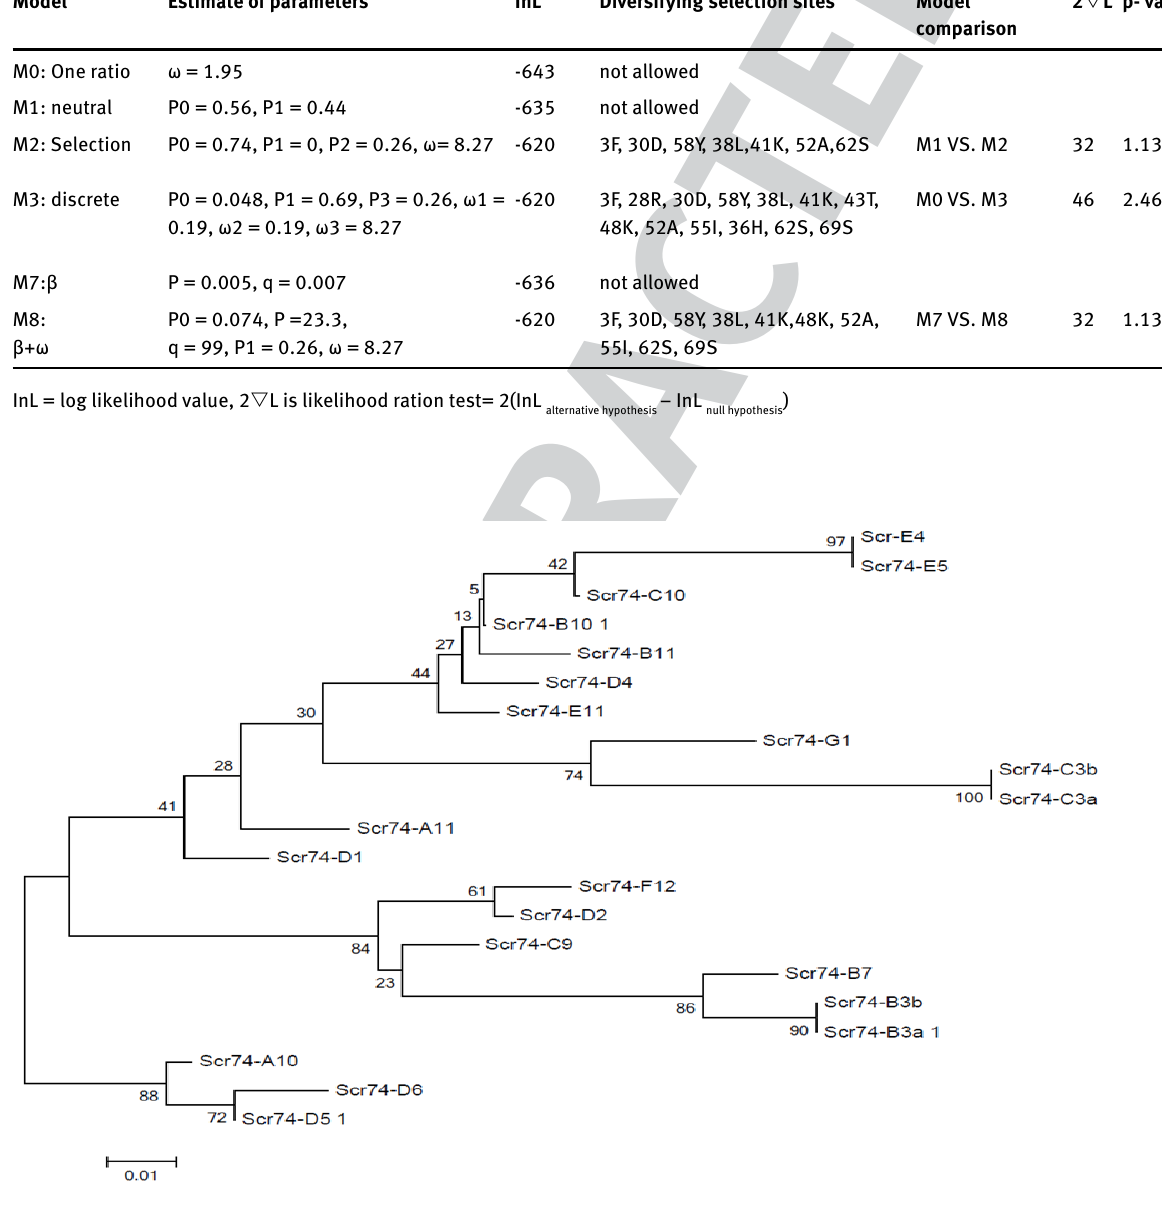
Figure 3. Evolutionary relationship of Scr74 variants after stop codon containing genes were removed